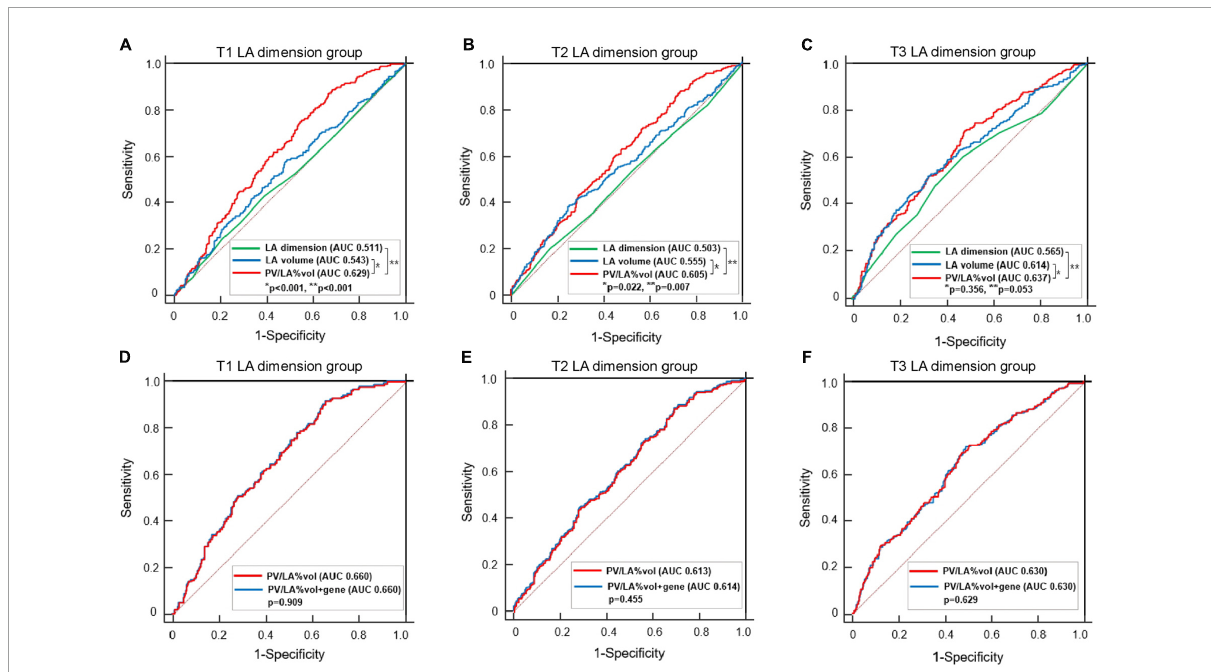
FIGURE4 Comparisons of the predictive value of AF recurrence among LA dimension, LA volume, PV/LA%vol, and PV/LA%vol with PITX2 genome in the tertile groups according to the LA dimension. Comparisons of AUCs between PV/LA%vol, LA volume, and LA dimension in the T1 (A) , T2 (B) , and T3 (C) LA dimension groups. Comparisons of AUCs between PV/LA%vol and PV/LA%vol with PITX2 gene in the T1 (D) , T2 (E) , and T3 (F) LA dimension groups. AF, atrial fibrillation; AUC, Area under the receiver operating characteristic curve; LA, left atrium or left atrial; PV/LA%vol, pulmonary vein to left atrium volume percent